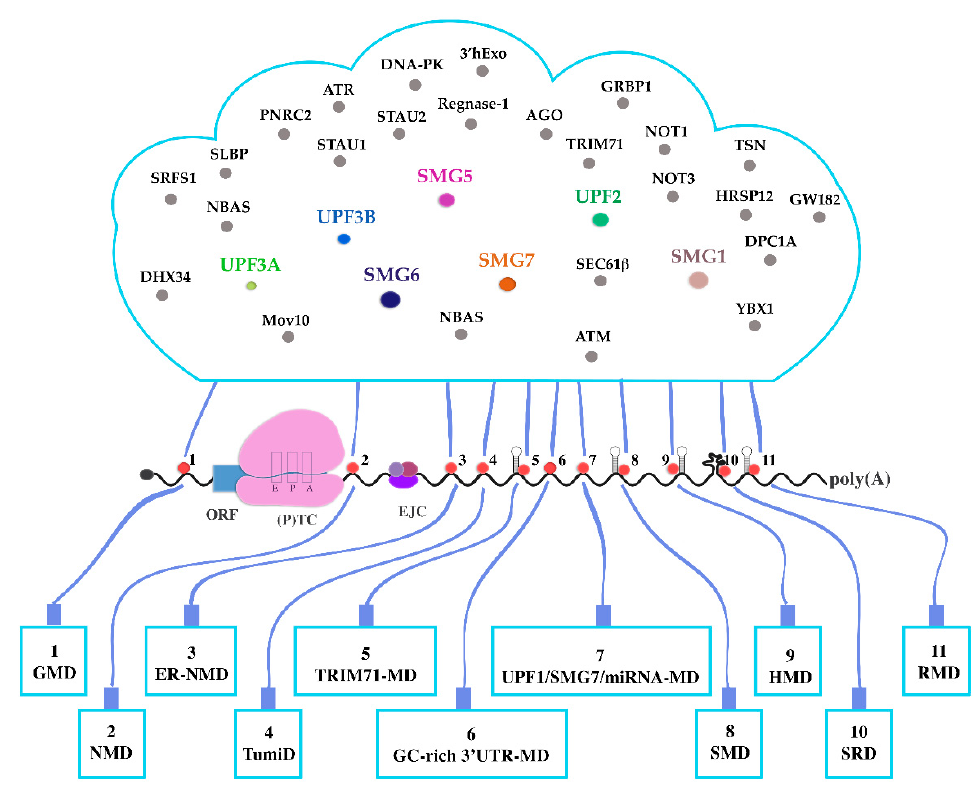
Figure 3. UPF1 “cloud”. The functioning of UMDs is compared to a network of users who all have access to a common “cloud”. UPF1 binds to or migrates to RNA stretches or structures. Depending on the UMD, binding is supported (or not) by other protein effectors, thus forming “condensation nuclei”. Pathway-specific condensation nuclei attract other effectors from a common pool. This pool is analogous to a computing cloud which contains shared and specific resources available on demand and according to the needs of the individual user (UMD). The UPF1-containing condensation nuclei are shown as red circles. UMDs are depicted as “end devices” connected to the “cloud” by “cables” through the condensation nuclei. Shared NMD-factors in the cloud are highlighted by colors. Other effectors that are specific for individual UMDs are shown in gray. Pathways 5, 8, 9 and 11 require dsRNA structures, shown as hairpins. Pathway 10 requires complex secondary 3 ′ UTR structures shown as a multiloop knot. Most UMDs imply UPF1 interaction with 5 ′ or 3 ′ UTRs. In the TumiD (pathway 4) UPF1 functions by dissociating miRNAs from target mRNAs. Most known UMDs (except 1 and 4) depend on translation termination at normal (TC) or premature (PTC) termination codons. The presence of an exon junction complex (EJC) considerably enhances NMD efficiency. Black curved line: RNA. Blue rectangle: ORF. Pink bipartite structure: terminating ribosome with the E, P and A sites; black circle: 5 ′ cap; poly(A): Poly(A)-tail.